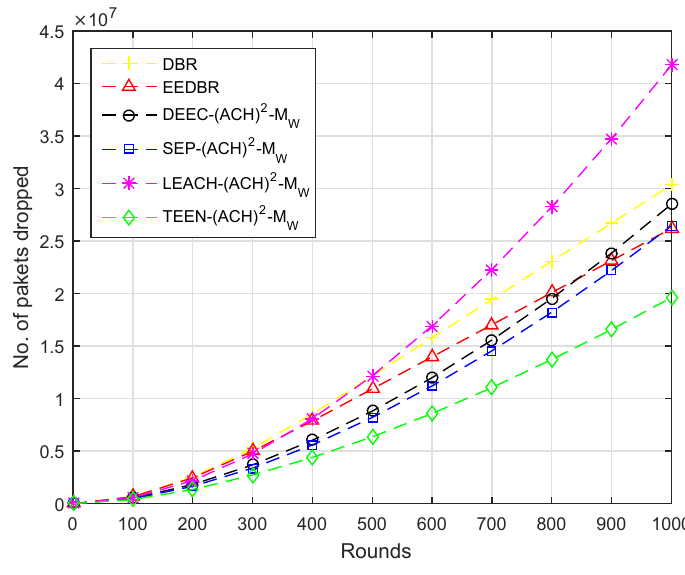
Figure 11. Number of Packets Dropped.